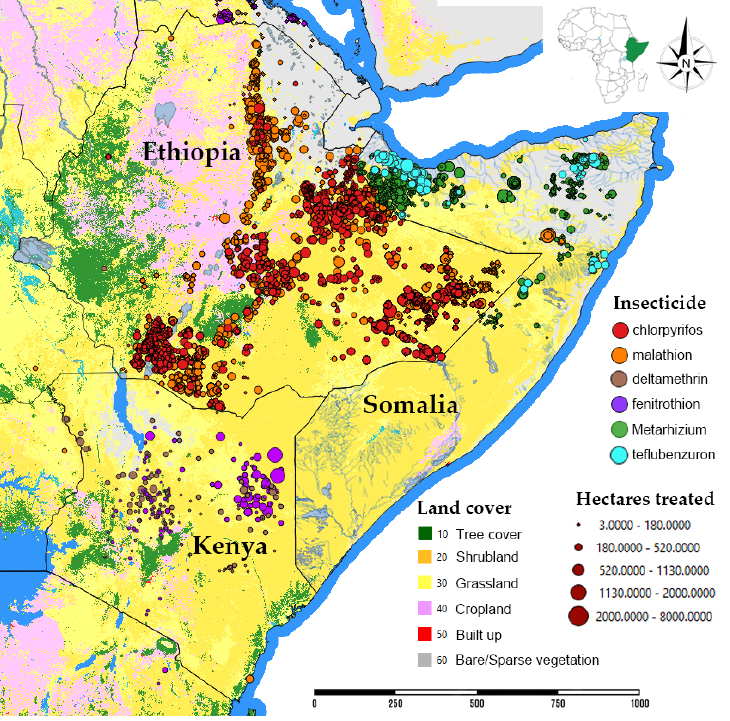
Figure 2. DL treatments from October 2019 to December 2021. Treatment data for Kenya are incomplete. Landcover in 10 m × 10 m resolution tile size 3 × 3 degrees [31]. Environmental impact monitoring was very limited during the campaign in East Africa. In the absence of surveys, knowledge of the impact of DL control on the environment is sparse. Nevertheless, based on the intrinsic ecotoxicity of products used, including insecticides not recommended for DL control, and from field research during previous campaigns since 1989, among others in the FAO Locustox Project [37,38] and during the 2003 – 2005 upsurge, it can be safely assumed that negative environmental side effects were widespread but remained largely unreported, with externalities unaccounted for [50,63]. Environmental field monitoring of side effects in Kenya was funded by the FAO during two missions between June and August 2020 in eight sites in Turkana County (in all sites, deltamethrin was applied) and five sites in Samburu County (one site treated with fenitrothion and four sites with deltamethrin) [15] and between October 2020 and January 2021 in two sites in Samburu County (one site with M. acridum and one site fipronil), and two sites in Marsabit County (both sites with deltamethrin) and two in Kitui County (both sites with fenitrothion) [16]. The sites consisted of shrubland, pastoral areas with or without trees, agricultural fields mainly with cereals and beans, and sensitive habitats with beehives and small settlements. On the three sites treated with fenitrothion that were monitored in Kenya, the product concentration was 960 g a.i./L which immediately predisposed the control operations for overdosing. In Samburu County, the insecticide was applied at a rate of 34 L/ha, which equals to a dose rate of 32,640 g a.i./ha (instead of the recommended dose rate of 400 g a.i./ha) by untrained applicators on cultivated land with settlements and sensitive habitats, leading to intoxications by the control agents, soil contamination, phytotoxicity (in maize) and mortality of nontarget arthropods, including honeybees [15]. The second